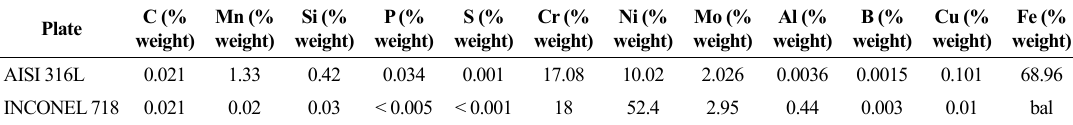
Table 1. Chemical composition of the austenitic stainless steel AISI 316L and the Inconel 718 alloy used, according to the manufacturer’s quality certificate Plate